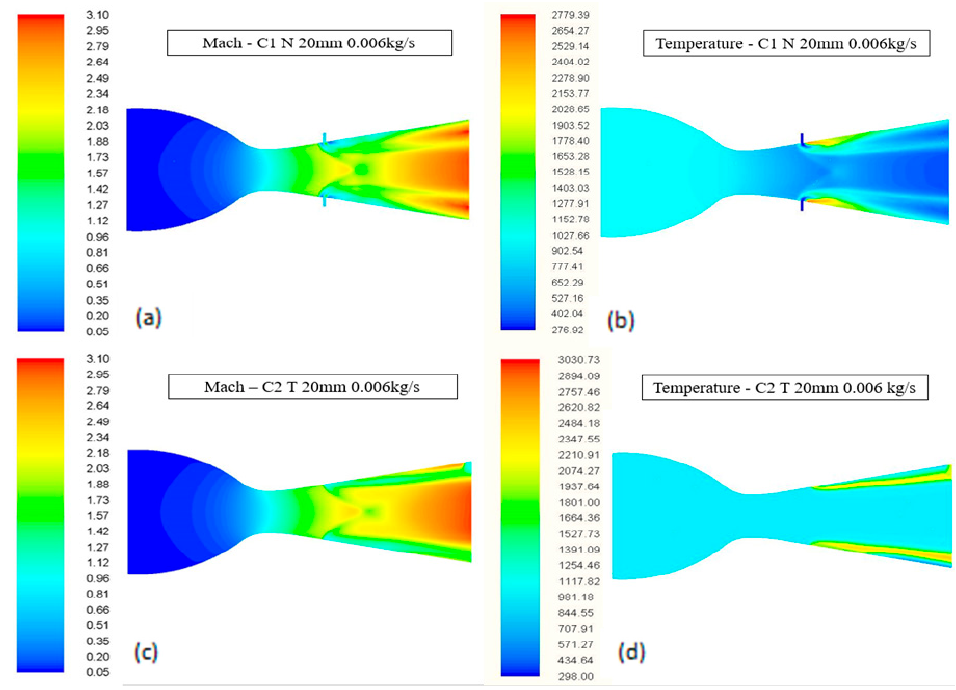
Figure 8. ( a , b ) Normal injection ‐ Mach number and static temperature. ( c , d ) Tangent injection ‐ Mach number and static temperature contours.